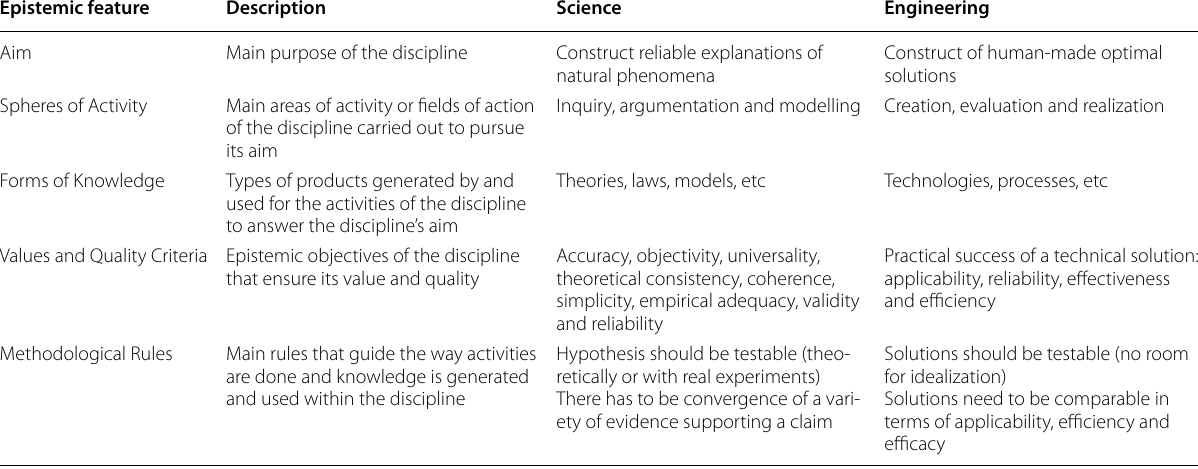
Table 2 Epistemic features of science and engineering (based on Couso & Simarro, 2020) Epistemic